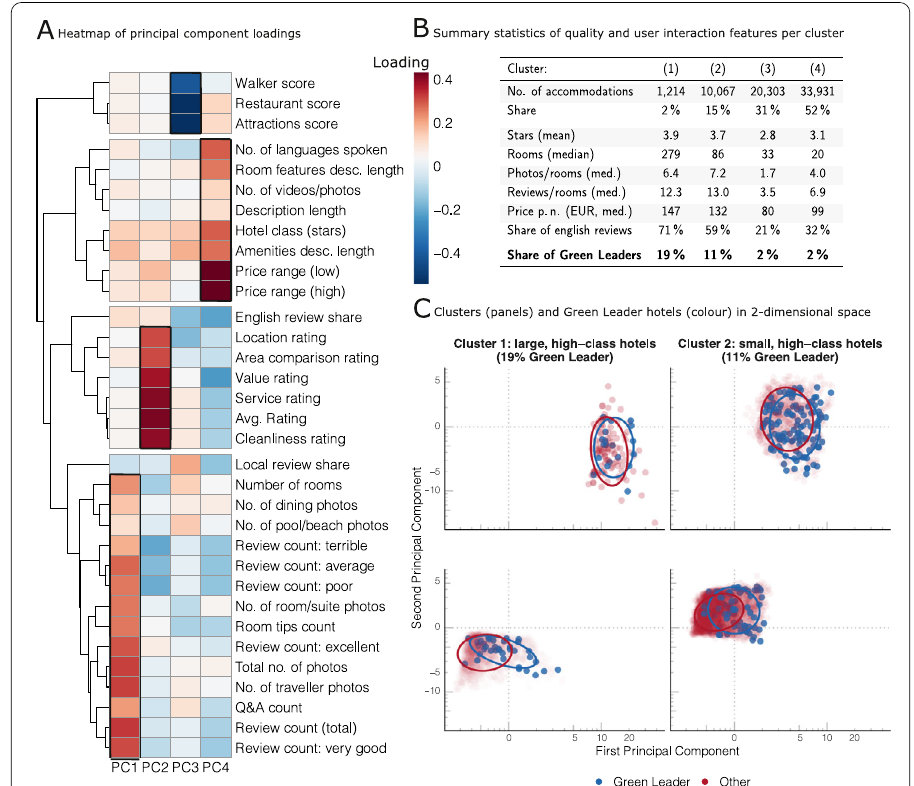
Figure 2 Unsupervised Learning techniques applied to TripAdvisor data. ( A ) Heatmap of principal component loadings of the four main principal components based on dimensionality reduction of the 33 continuous variables in the data set. The algorithm identifies four main dimensions in the data: accommodation size and user interaction (PC1), user rating (PC2), location (PC3), and quality (PC4). ( B ) Summary statistics of four clusters identified by k-means clustering. The accommodations can be grouped according to quality and user interaction variables. The clusters show different proportions of the GreenLeader outcome variable, varying from 2% to 19%. ( C ) Two-dimensional representation (PC1, PC2) of TripAdvisor data (10% sample) grouped in four clusters (panels) and GreenLeader/other accommodations (color). The unsupervised learning algorithms are able to split the data into distinct groups with varying proportions of GreenLeader